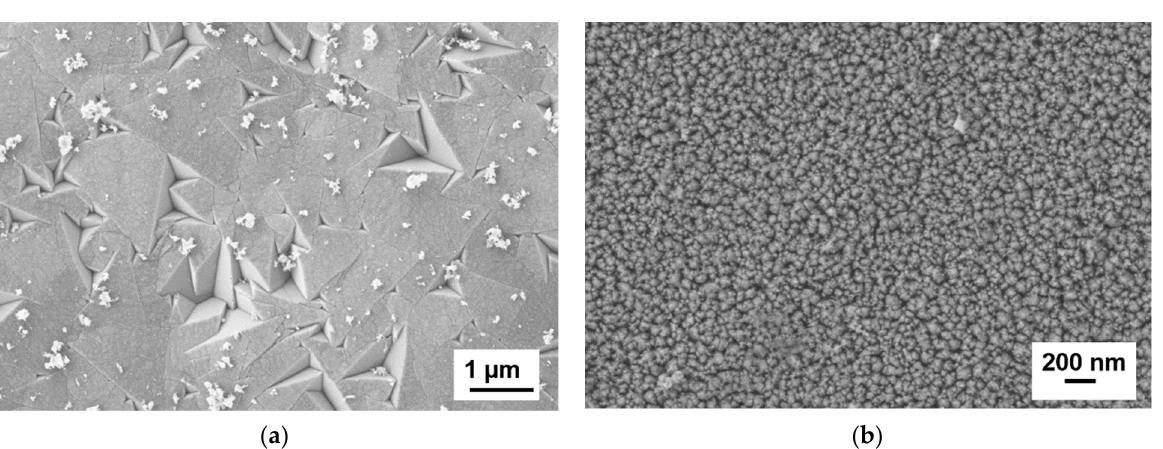
Figure 4. Lattice constants of fcc-Ti 1 − x Al x N layers as function of x according to Vegard‘s law for PVD layers and for the fcc-Ti 1 − x Al x N phase in the CVD layer of this work. The green line shows the linear Vegard’s plot and the red line presents the progression based on experimental data of PVD layers.